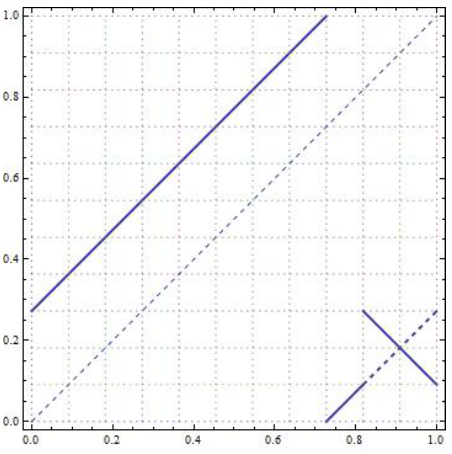
Figure 12. The graph of a ( 3,1 ) -IET with permutation ( 3,1, − 2 ) and λ = ( 8,1, 2 ) . The dotted line in interval I 3 is the graph of the rotation R